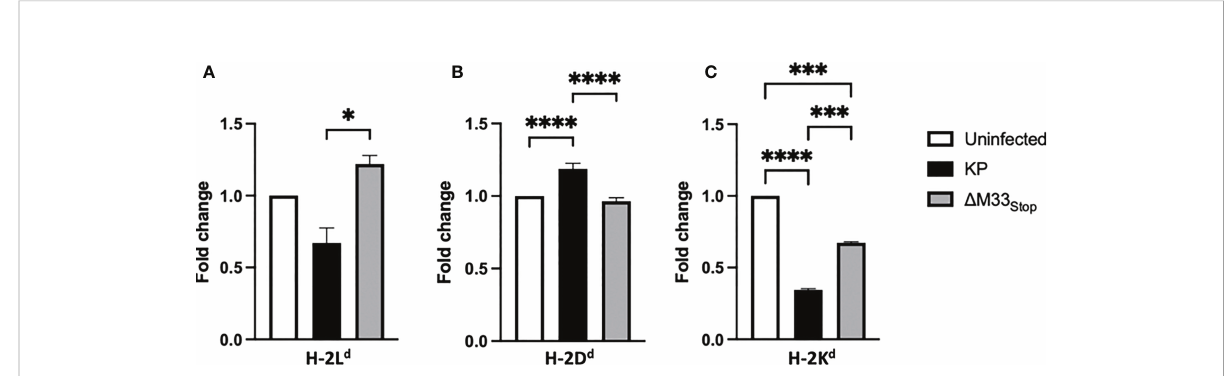
FIGURE 8 M33 alters MHC expression. mSGM cells were infected at an MOI of 5 with either KP or D M33 stop . 12 hours post infection, cells were stained and analyzed by fl ow cytometry. Fold change indicates the ratio of cell expressing high levels of H-2L d (A) , H-2D d (B) , and H-2K d (C) compared to uninfected control cells. H-2L d is the MHC isotype responsible for presentation of the IE1 immunodominant peptide and H-2D d is responsible for presenting the m164 immunodominant peptide. Signi fi cance is shown as *p<0.05; ***p<0.001; ****p<0.0001. Data represent 3 experiments run in duplicate (total